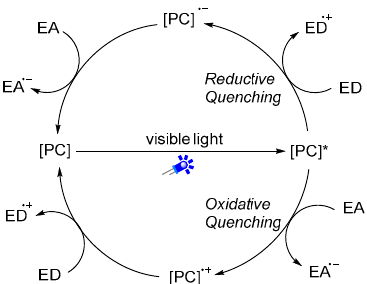
Figure 3. General mechanism of visible-light-driven photoredox catalysis.